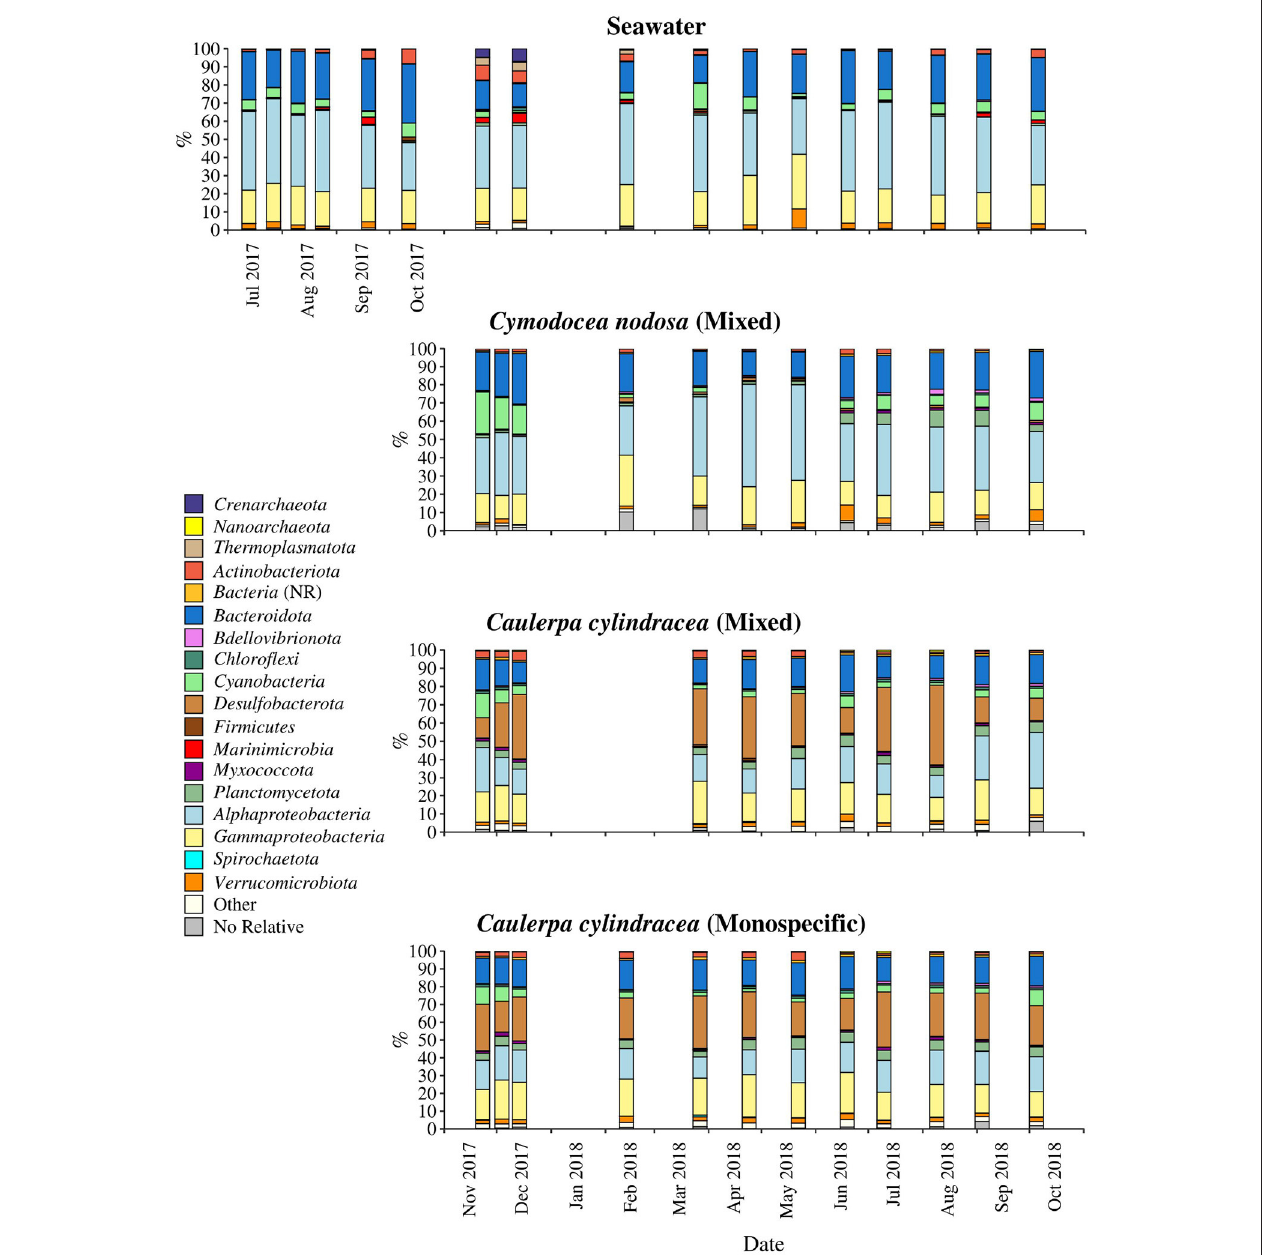
FIGURE 4 | Taxonomic classification and relative contribution of the most abundant ( ≥ 1%) bacterial and archeal sequences on the surfaces of the macrophytes C. nodosa (mixed settlement) and C. cylindracea (mixed and monospecific settlement) and in the ambient seawater. NR, no relative (sequences without known relatives within the corresponding